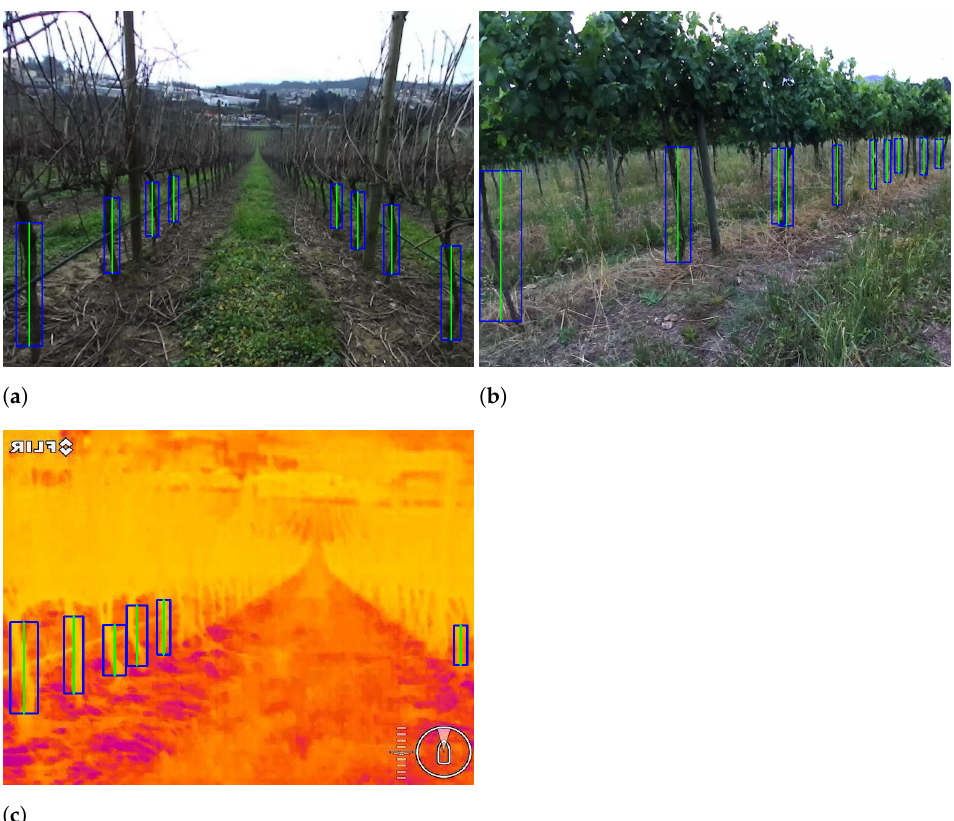
Figure 10. Detection results in ( a , b ) two RGB images from different vineyards and ( c ) one thermal image using Single Shot Multibox Detector (SSD) MobileNet-V1 trained with